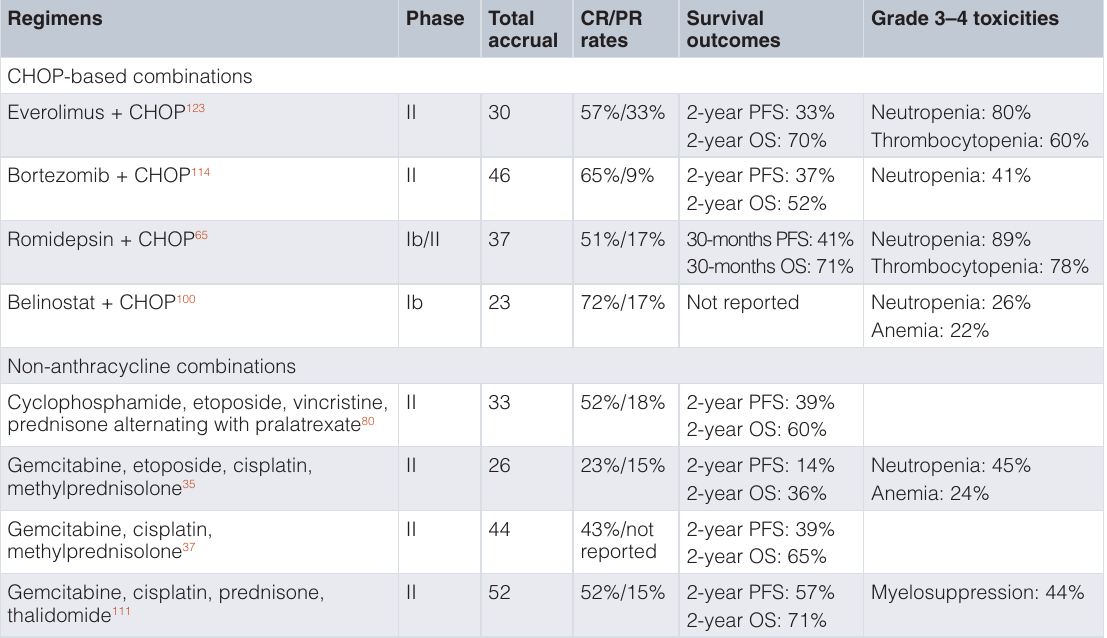
Table 1. Summary of the recent trials of front-line treatment for peripheral T-cell lymphoma.